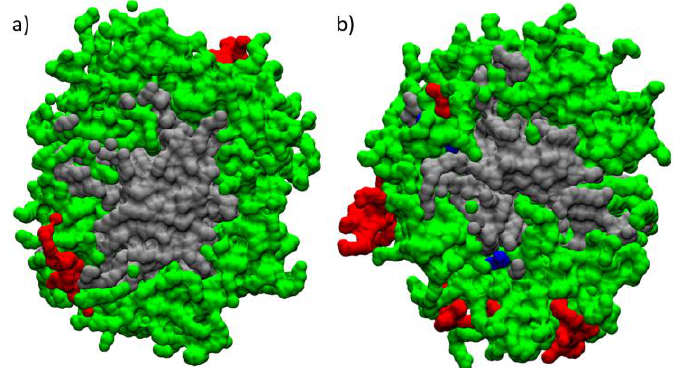
Figure 10. Snapshot of the mixed micelles of Tween ® 80 (red surf) and Gelucire ® 44/14 (green and gray surf) in the ( a ) absence and ( b ) presence of Miglyol ® 812 (blue surf) at 358 K, along with a cross-sectional view 200 ns into the simulation trajectory.